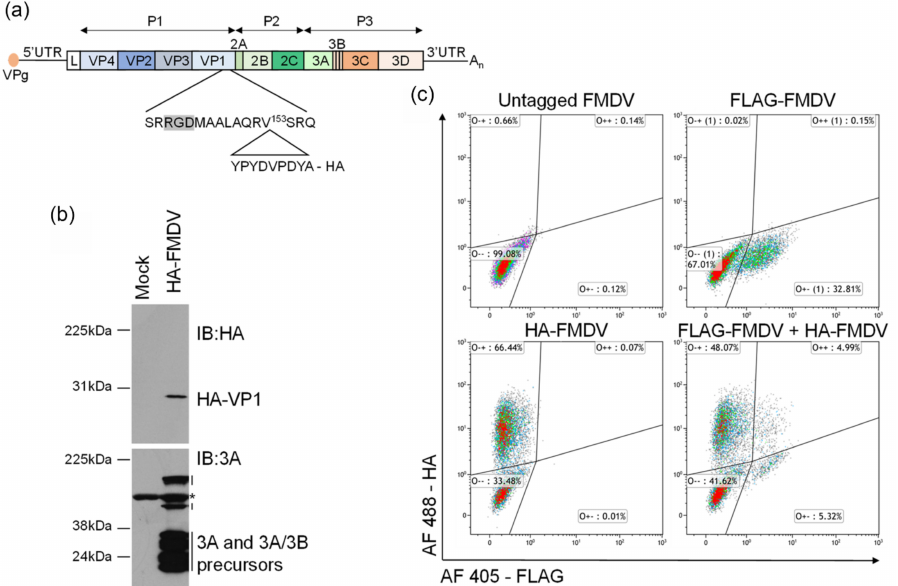
Figure 3. Co-infection of goat epithelium cells with HA-FMDV Asia 1/O1K and FLAG-FMDV O1K/O UKG35. ( a ) Schematic diagram showing the position of the tag insertion in the FMDV Asia 1/O1K infectious clone. ( b ) Confluent monolayers of cells were mock infected or infected with HA-FMDV Asia 1/O1K (MOI = 1). Whole cell lysates were analysed for the presence of HA-tagged VP1 by immunoblotting (IB) with an antibody to the HA tag, and non-structural protein 3A (and 3A/3B precursors) with the 2C2 mAb. * indicates a non-specific cross-reacting cellular protein which demonstrates equal loading. ( c ) Cells were infected with untagged FMDV O1K/O UKG35 (MOI = 1), FLAG-FMDV O1K/O UKG35 (MOI = 1), HA-FMDV Asia 1/O1K (MOI = 1), or co-infected with FLAG-FMDV O1K/O UKG35 and HA-FMDV Asia 1/O1K (MOI = 0.5/virus) for 5 h. Cells were fixed, permeabilised and labelled with anti-HA and anti-FLAG antibodies and analysed by flow cytometry. The percentage of cells positive for HA only (O-+), FLAG only (O+-) and HA plus FLAG (O++) are